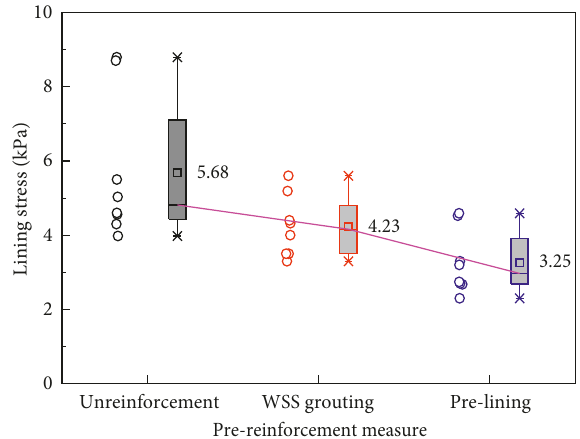
Figure 12: Incremental variation of ultimate lining